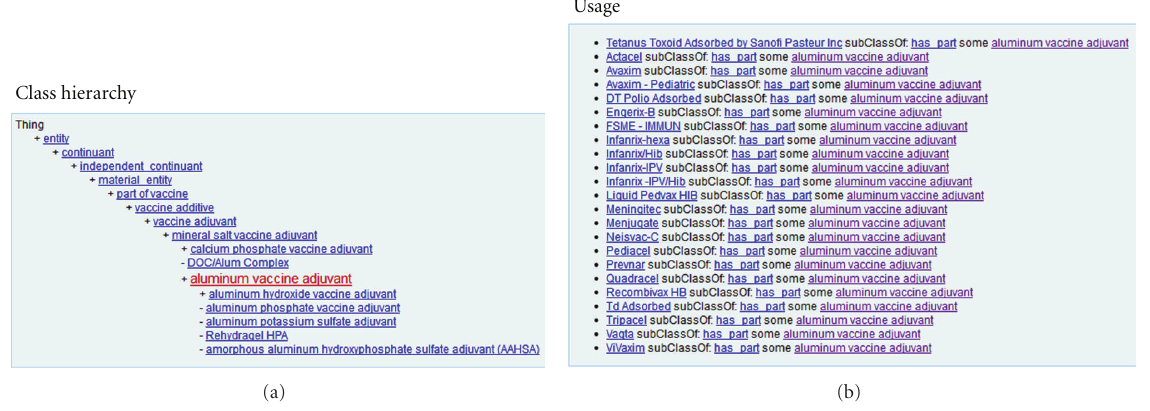
Figure 3: Modeling and application of vaccine adjuvants in the Vaccine Ontology (VO). (a) The hierarchical structure of vaccine adjuvants in VO. (b) All the vaccines that use this adjuvant. The usage information is obtained by a SPARQL query based on the logical definitions of vaccines. The website that contains this information is http://purl.obolibrary.org/obo/VO 0000884.